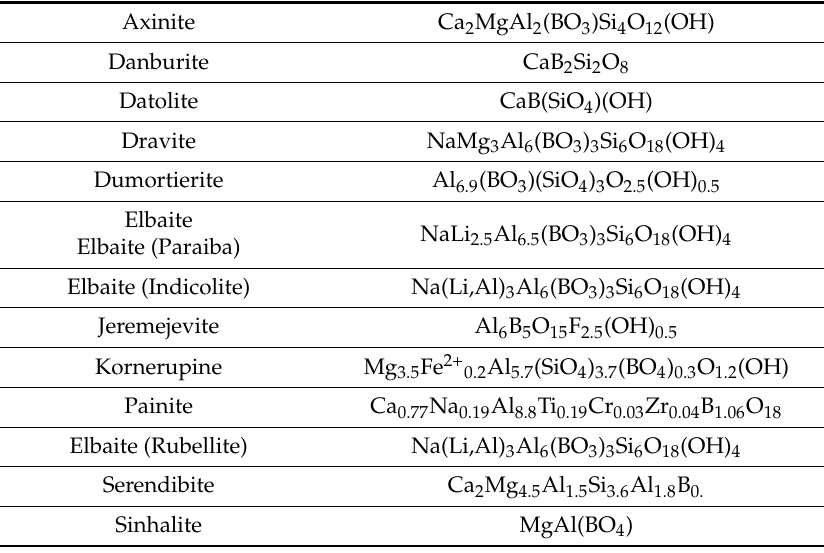
Table 2. Boron-bearing minerals, achieving locally, gem quality